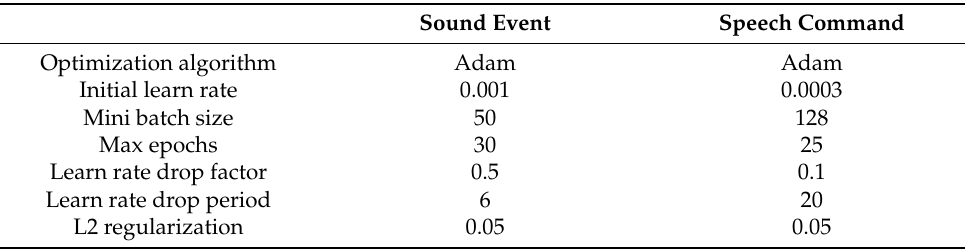
Table 2. Optimization algorithm and hyperparameter settings for training the CNN.